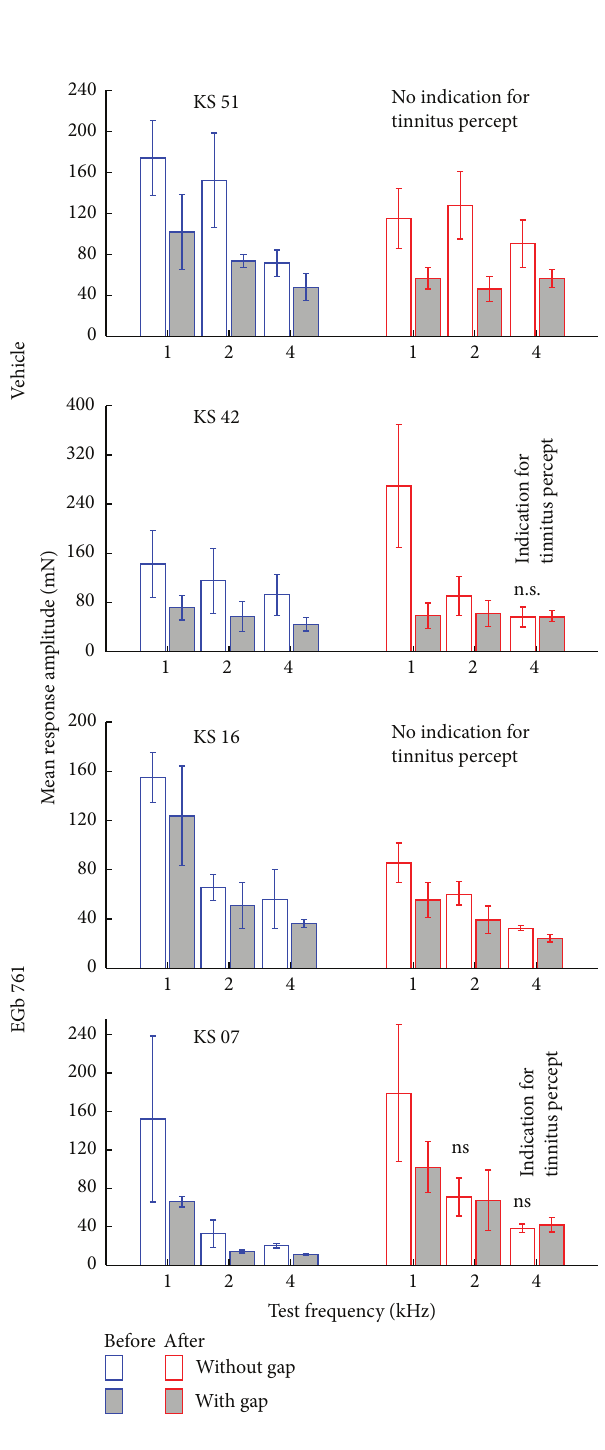
Figure 4: Results of the gap-noise PPI of the ASR in four exemplary animals. Given are the mean response amplitudes in mN ( ± standard deviation) for the two noise conditions: without gap (open bars) and with gap (filled bars) before (blue) and after (red) the trauma for all 3 frequencies tested (averaged for both gap noise paradigms). The upper two animals received the vehicle and the lower two animals received the EGb 761 extract before the trauma. All gap conditions produced significantly ( 𝑡 -tests) lower ASR amplitudes before the trauma. In some animals (KS 51 and KS 16) this was also true for the “posttrauma” condition and was a first indication for NT categorization. In other cases (KS 42 and KS 07) gap detection was impaired and did not show any significant change after the trauma at least at some frequencies; this was a first indication of T categorization (cf. Section